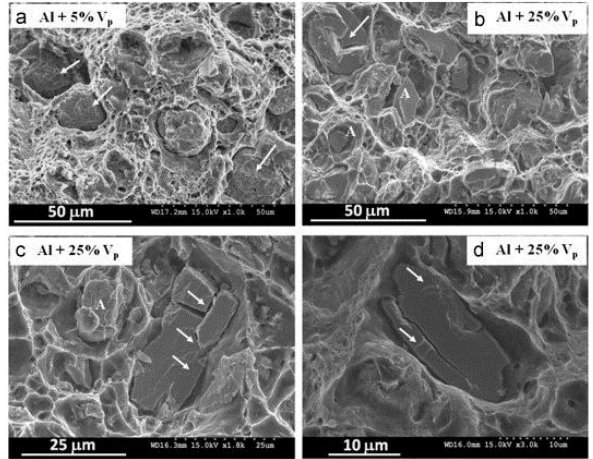
Figure 4. ( a , b ) Low magnification and ( c , d ) high magnification fractographs of Al-Ni 60 Nb 40 composites fractured under tensile loads. White arrows indicate better interfacial bonding between particle and matrix with no particle debonding in ( a & b ), small sized particles remaining intact marked as ‘A’ in ( b & c ), high aspect ratio particles undergoing multiple cracking and fracture in ( c ) and vein patterns caused by strain localization in amorphous particles in ( d ) (reprinted from Jayalakshmi et al . 2014 [7], with permission from ©